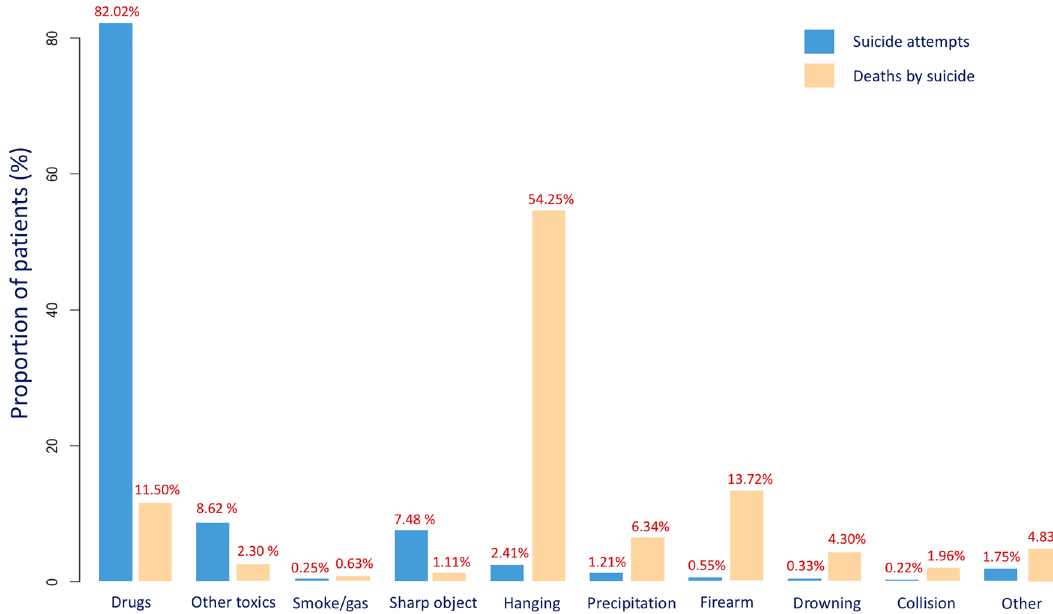
Figure 2. Bar chart representation of the suicidal means used in France, over the 2009–2018 period for suicide attempts and over the 2009–2015 period for suicides.